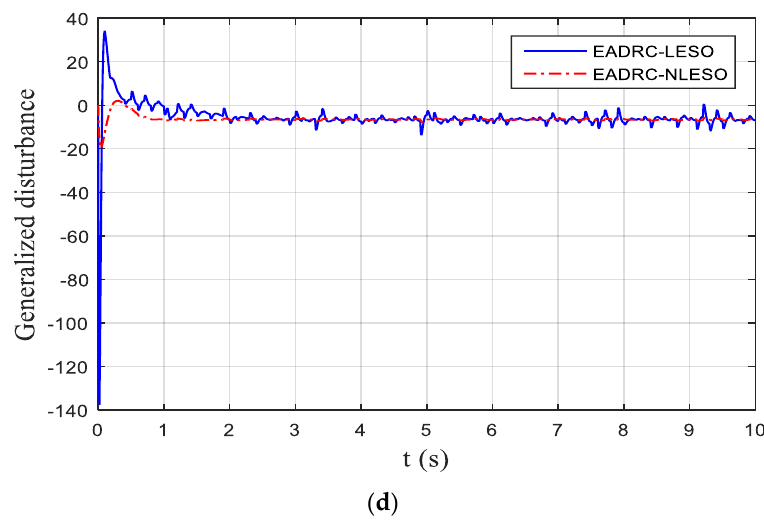
Figure 5. The numerical results for PMDC motor of Equation (27) with measurement noise.